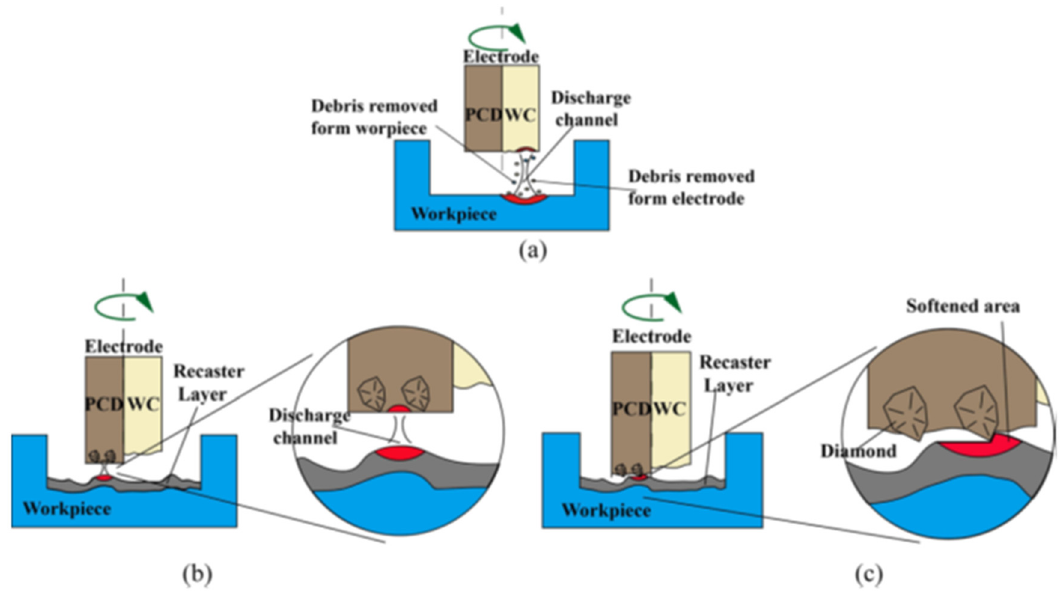
Figure 26. (a–c) Alternating energy electrical discharge machining (AE-EDM) process [136]. (With kind permission from Elsevier).